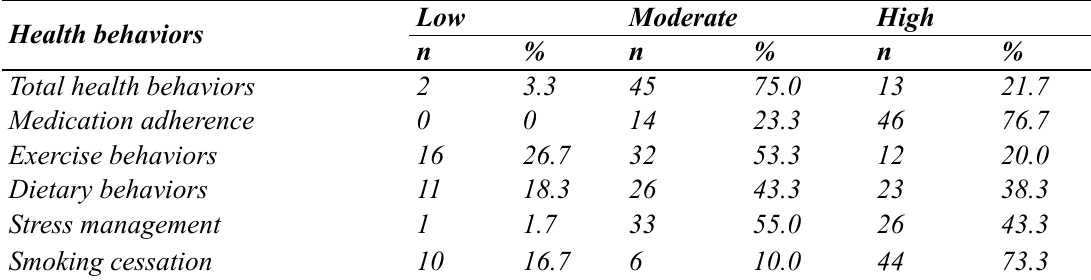
Table 3. Frequency and percentage of level of health behaviors (N = 60) Health